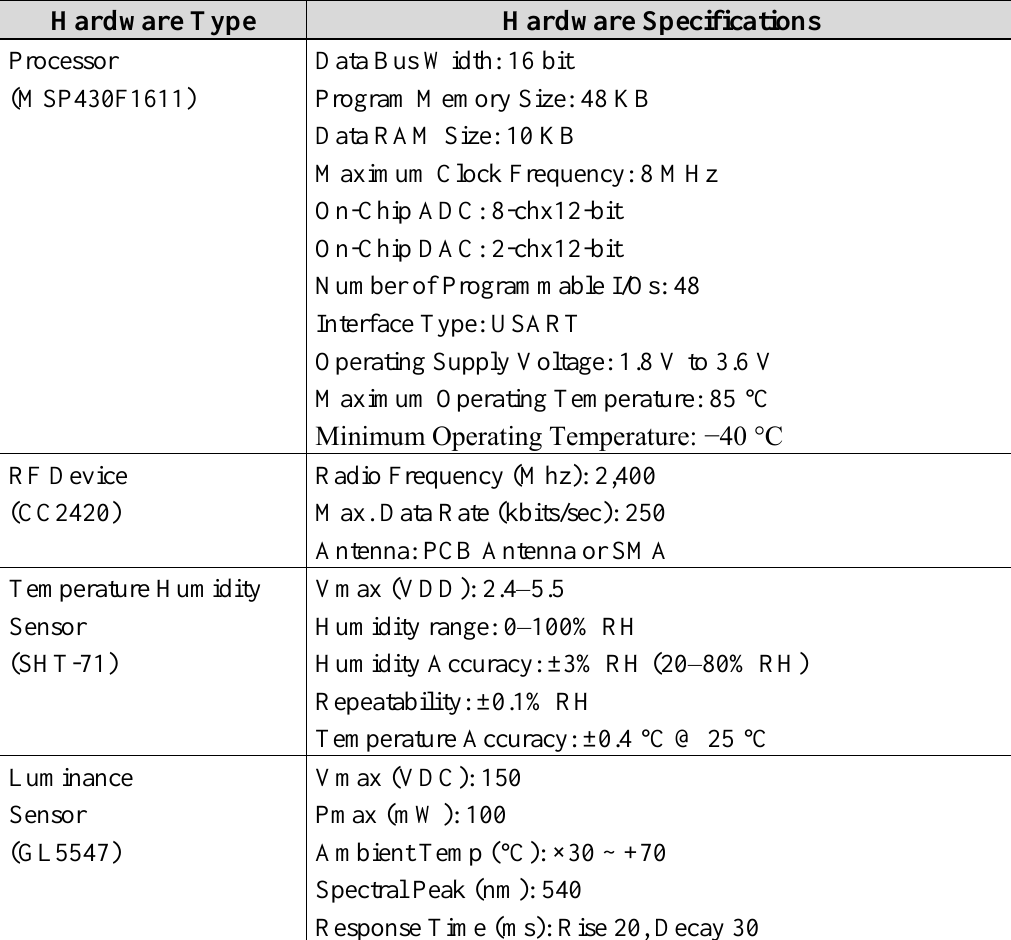
Table 2. Hardware Specifications of the Environmental